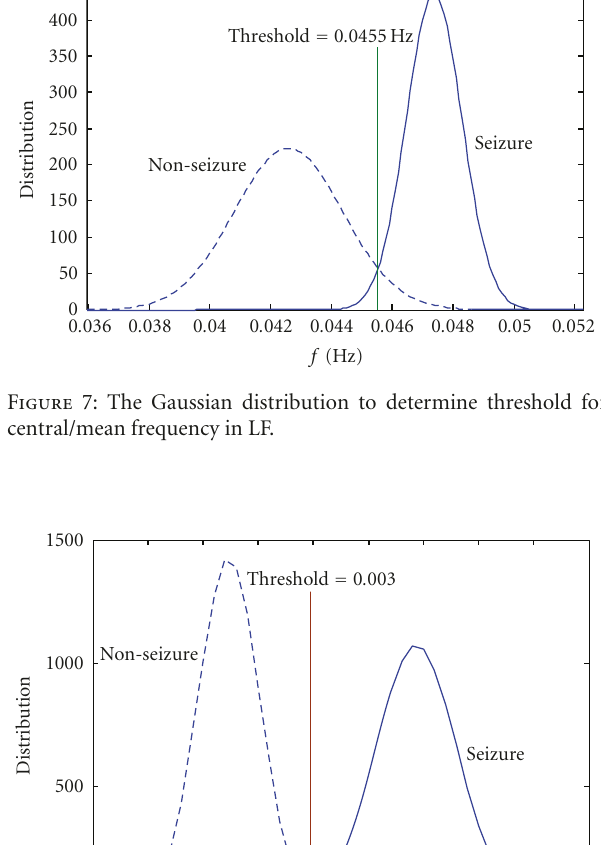
Table 2: Results for the central/mean frequency.